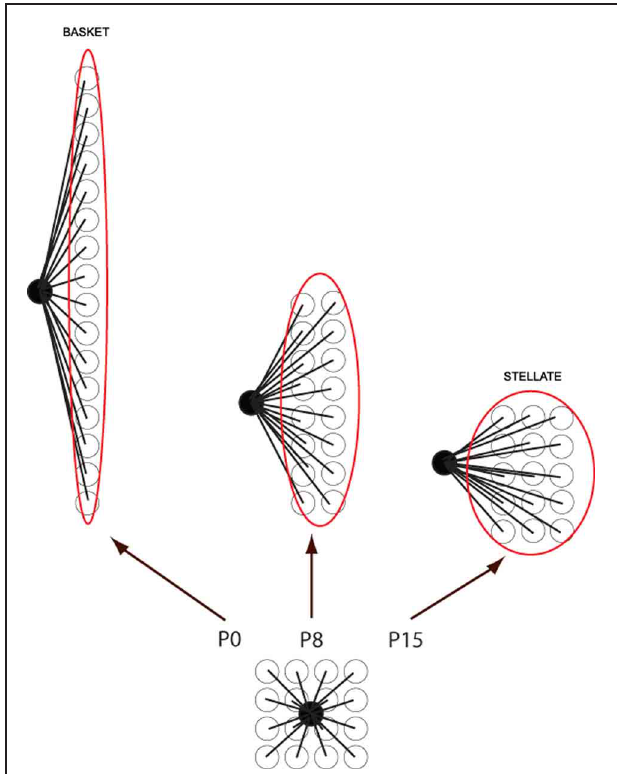
FIGURE 5 | Cartoon to show how basket/stellate cell parasagittal orientations might arise. Newly migrated basket/stellate cells enter the molecular layer and synapse on a small group of PCs. As the PCs extend parasagittally to form adult stripes, the basket/stellate cell arbors extend with them. As a result the shape of the final axonal arbor depends on the time they arrive: the earlier they enter the molecular layer, the more extended the arbor ( = basket cell), the later they enter, the less it is extended ( = stellate cells).